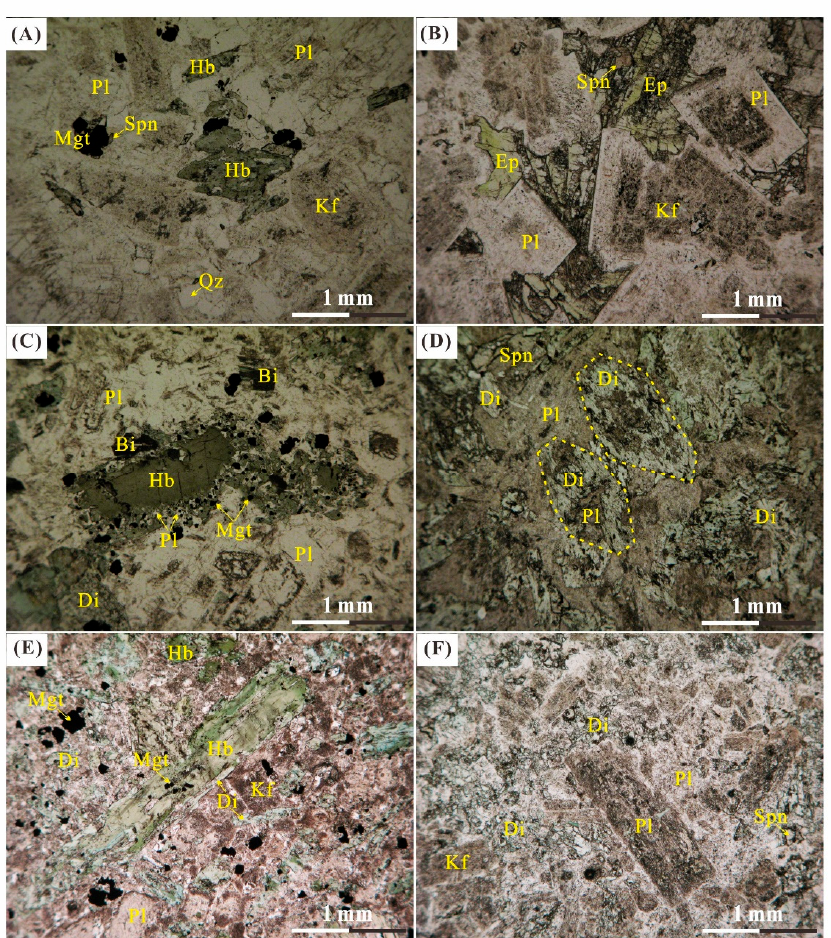
Figure 2. Microphotographs in transmitted light illustrate the characteristics of altered plutonic rocks from the Han-Xing iron deposit. ( A ) Fresh quartz diorite (FS-01) with medium-grained equigranular texture; it is characterized by fresh euhedral hornblende. ( B ) Intensively altered quartz diorite (FS-02); hornblende has been replaced by epidote without magnetite residual. ( C ) Less altered diorite (FS-03); at the edge of hornblende, it has been altered to the aggregates of diopside, albite, magnetite and biotite. ( D ) Intensively altered diorite (FS-04); euhedral hornblende has been totally replaced by the diopside remaining with its previous morphology. ( E ) Less altered monzodiorite (BJ0818-23); hornblende has been altered to the diopside and magnetite. ( F ) Intensively altered monzodiorite (BJ0818-21); hornblende and magnetite have been dissolved from the monzodiorite, leaving the plagioclase and diopside